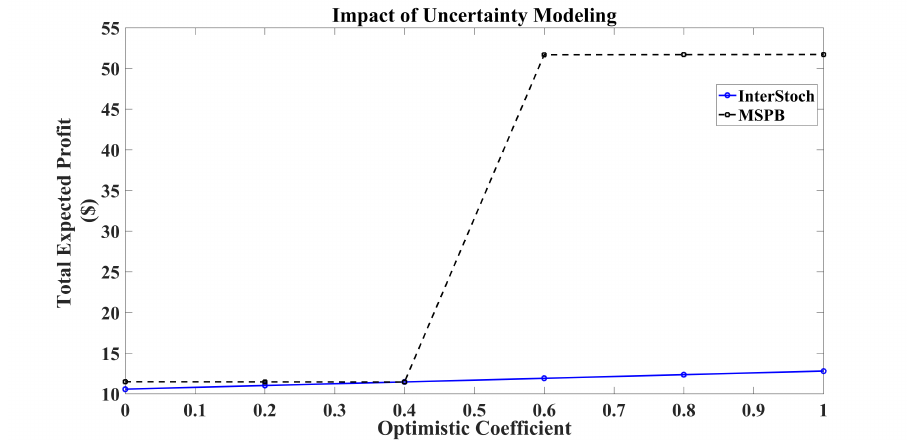
Figure 3. Impact of uncertainty modeling on the total expected profit of the system. Table 5. Impact of uncertainty modeling on day-ahead, real time and total expected profits under the